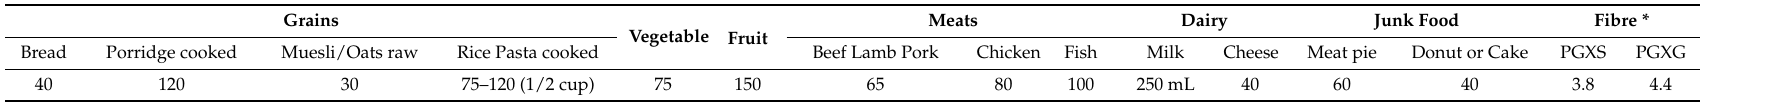
Table 1. Serve size in g or mL National Health and Medical Research Council (NHMRC), 2013 [27]. Fibre is 1 serve (g), with 2.5 serves daily minimum recommended